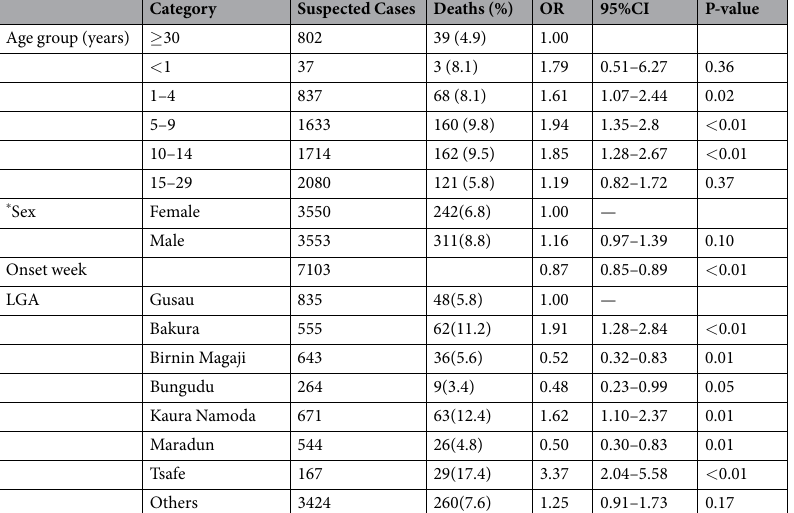
Category Suspected Cases Deaths (%) OR 95%CI P-value Age group (years) ≥ 30 802 39 (4.9)